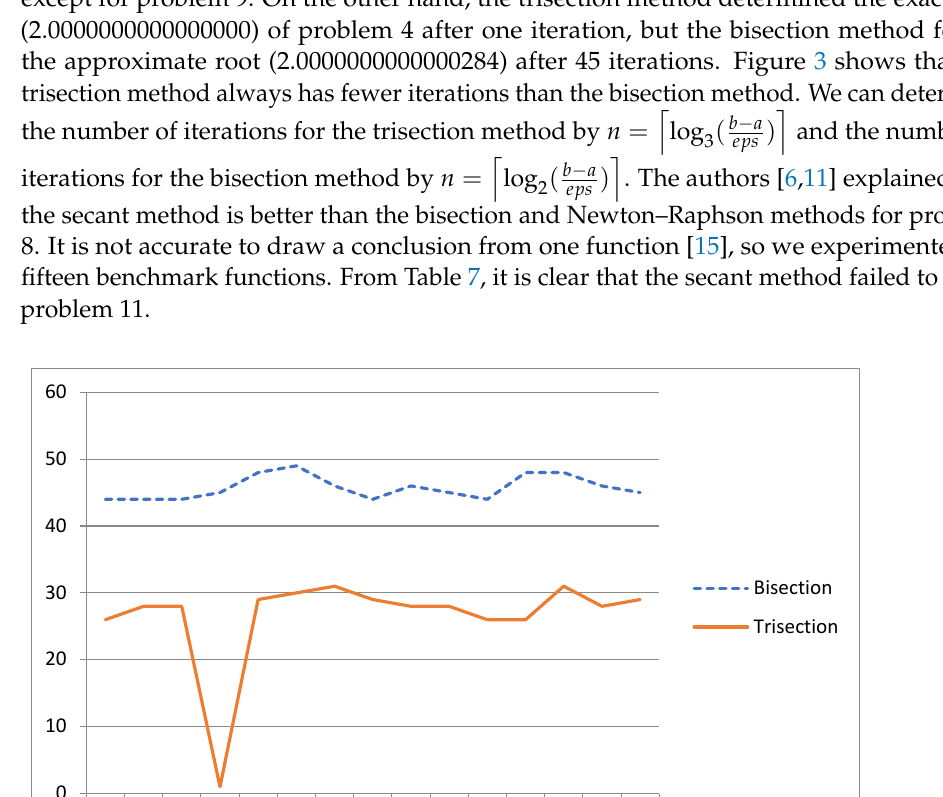
Figure 3. A comparison among 7 methods on 15 problems according to the CPU time. From Tables 5 – 7, we deduce that the proposed hybrid algorithm (trisection-false position) is better than the Newton – Raphson, false-position and secant. The Newton – Raphson method failed to solve problems P6, P9 and P11, and the secant method failed to solve P11.